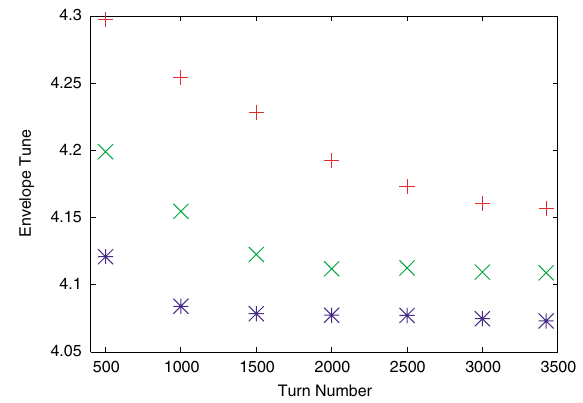
FIG. 17. (Color) Envelope tune (as calculated by a PCM model) versus turn number for (cid:4) (green (cid:2) ’s), and (cid:4)